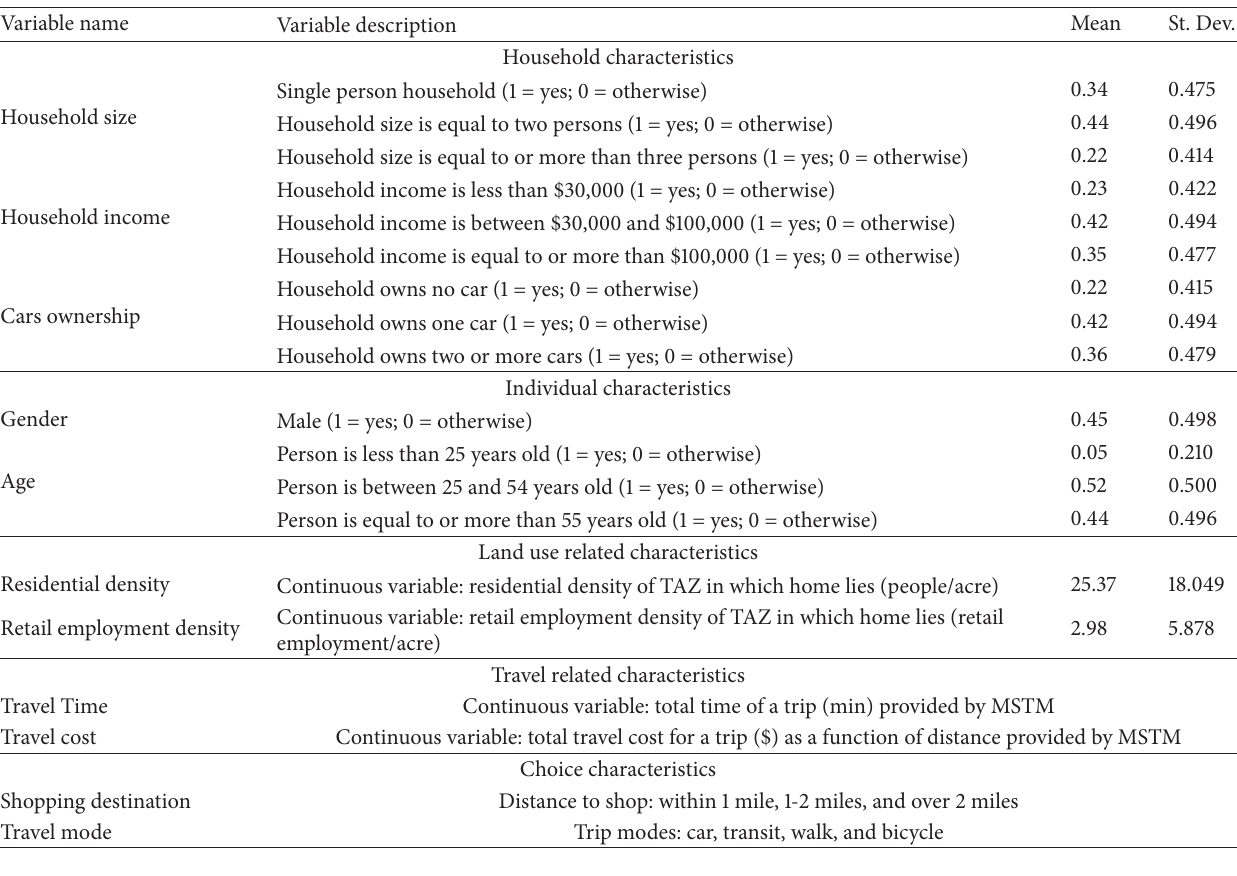
Table 2: Descriptive statistics of the sample data for home-based travel-to-shop trips ( 𝑁 = 975 ).